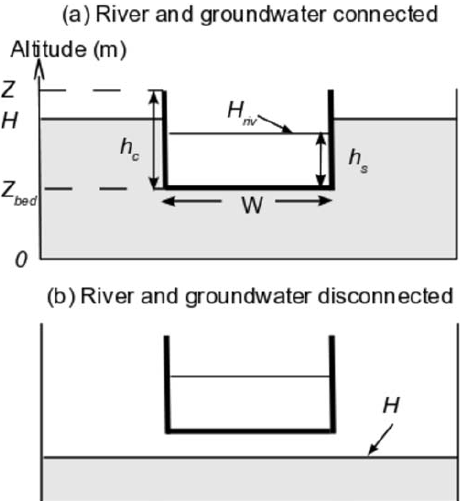
Fig. 1. Groundwater-river interactions with river and groundwater (a) connected and (b) disconnected. The geometry of the river is also